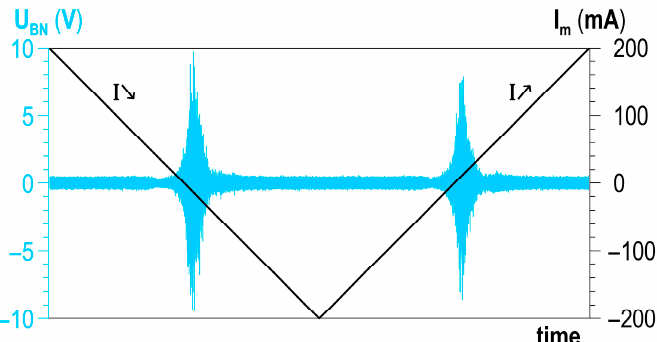
Figure 11. Detailed description of a single cycle of changes in magnetisation.